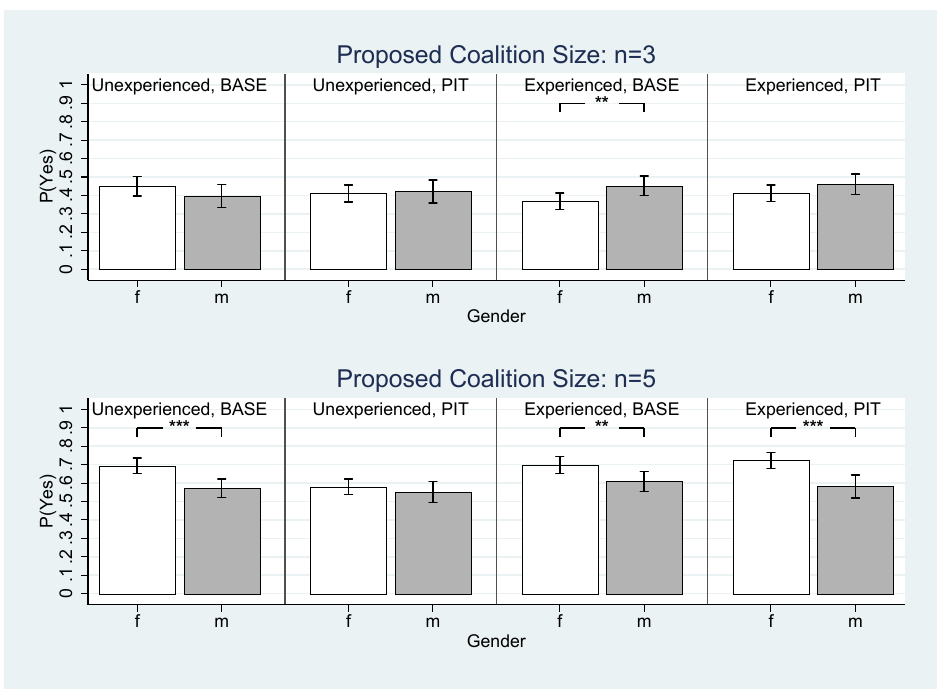
Figure 9. Responder’s Probability to Vote “Yes” by Proposed Coalition Size, Experience, Treatment, and Gender. The number of observations for each bar, means, and standard errors, as well as t -tests can be taken from Table A8 in Appendix A. Significance levels: * p ≤ 0.10, ** p ≤ 0.05, *** p ≤ 0.01. Error bars represent 90% confidence